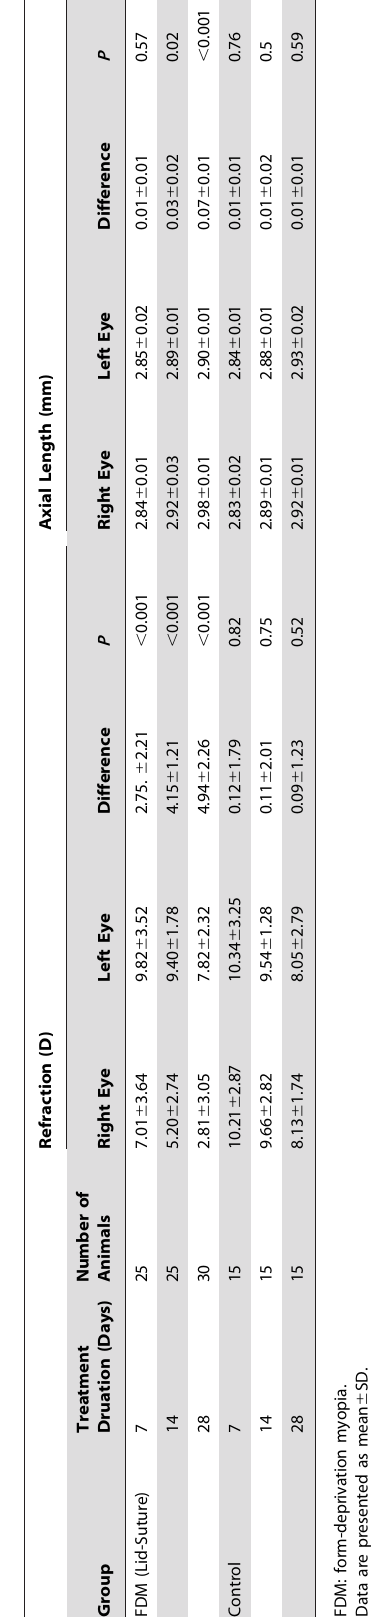
Figure 2. Natural trends of retinal Wnt2b, Fzd5 and b -catenin mRNA expression within 7 weeks after birth in normal mice. The expression level of the 3-week mice was defined as 1, and the values were normalized to those of b -catenin mRNA levels. Retinas from both eyes of 9 mice were used at each age. Data are presented as mean 6 SEM. (* P , 0.05 and ** P ,